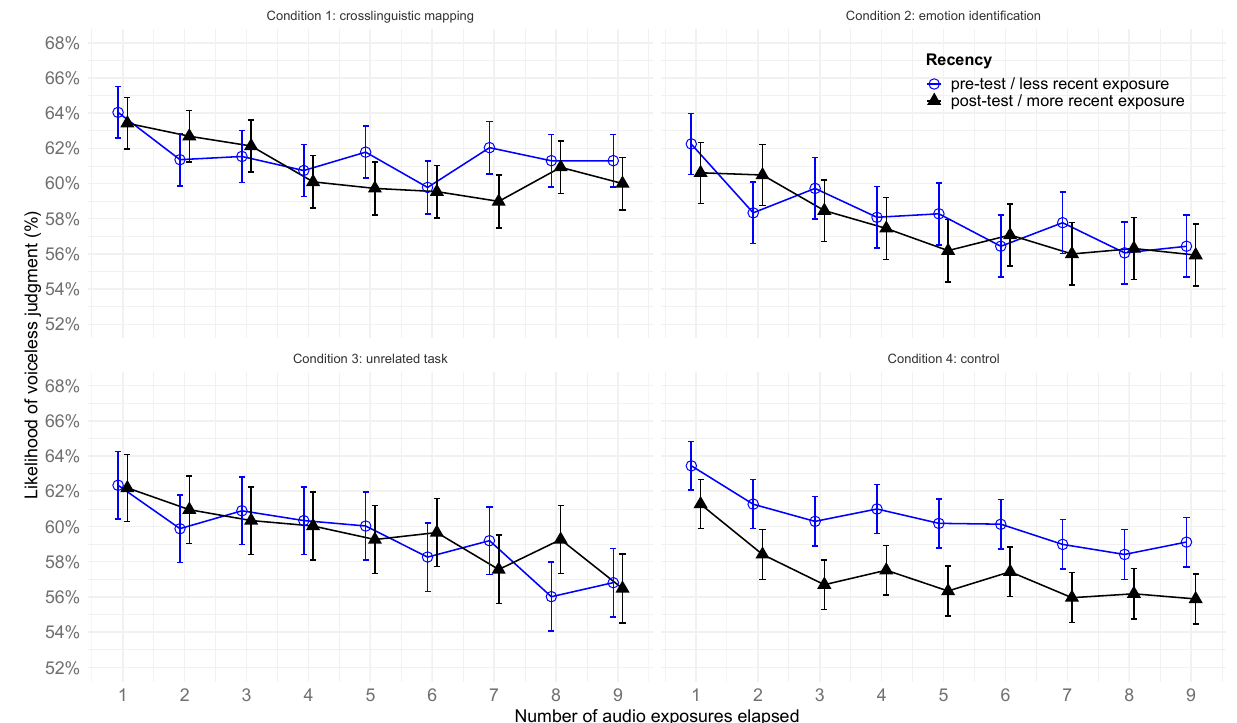
Figure 11. Likelihood of voiceless identification (averaged over bilabials and velars), by task condition, number of audio exposures (1–9), and recency of exposure. Error bars indicate standard error.